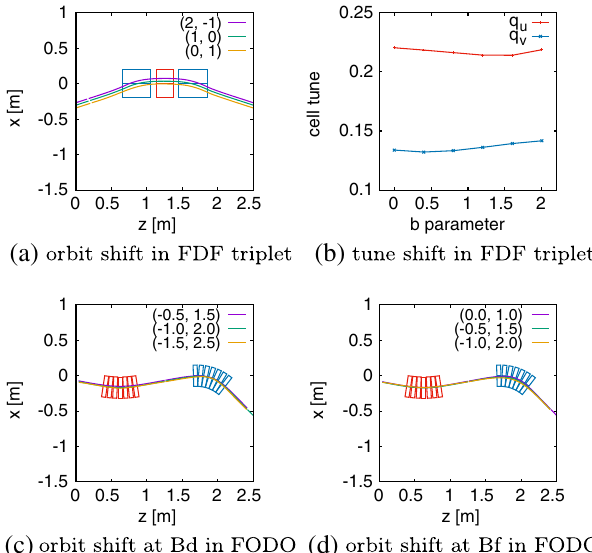
FIG. 5. Orbit shift controlled by a double coil design. (a) oribt shift in FDF triplet, (b) tune shift in FDF triplet, (c) orbit shift at Bd in FODO, (d) orbit shift at Bf in FODO. A bracket ð b; 1 − b Þ indicates the relative excitation of outer coil b to inner coil 1 − b . The total excitation is kept at unity. By having different excitation patterns of outer and inner coils, the orbit position can be controlled with little change of tune.